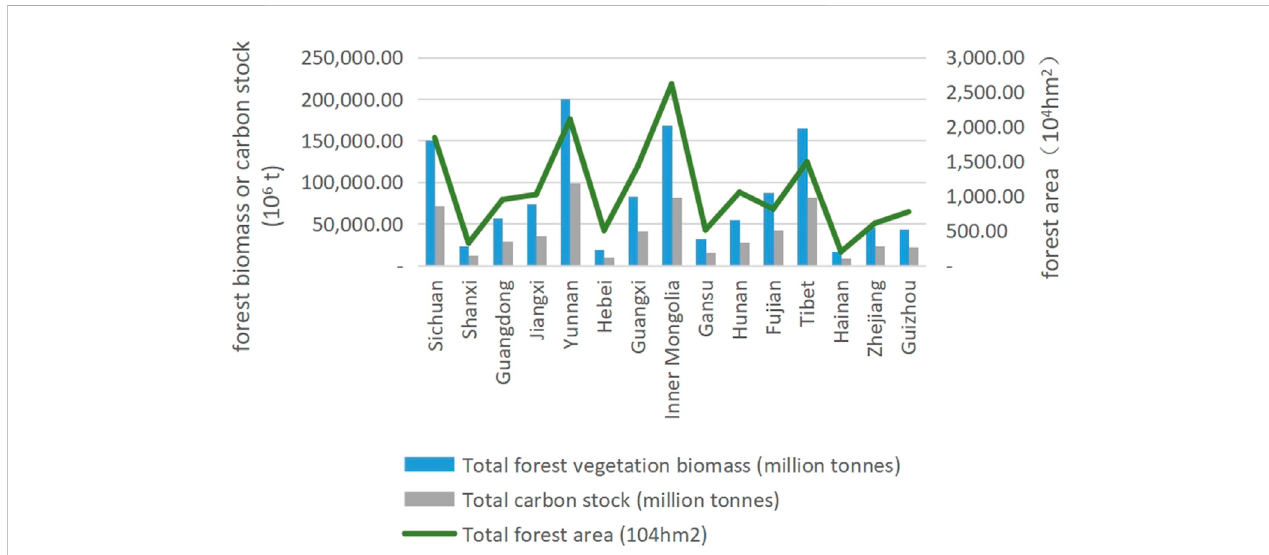
FIGURE 3 Forest characteristics of the sample provinces. Data source: China Forest Resources Report 2014 – 2018 , China Forestry Press, 2019 (5). Note: Figure 3 representstheforestcharacteristicsofthesampleprovinces,with theprimary axisshowingthetotalforestbiomass andtotalcarbon,bothinmilliontons, and the secondary axis showing the forest area, in million